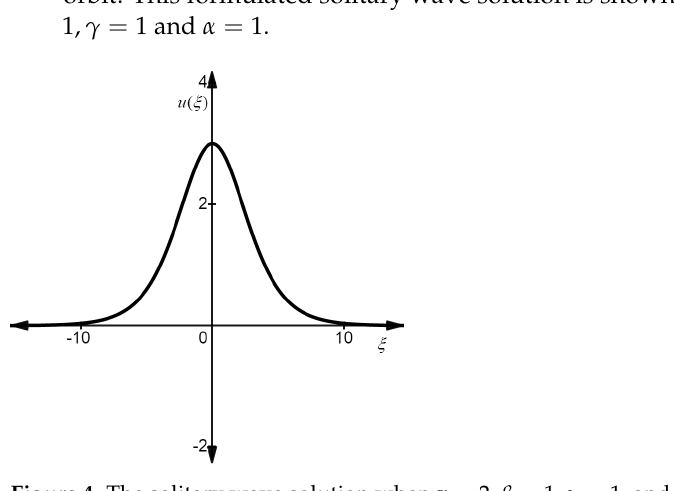
Figure 4. The solitary wave solution when v = 2, β = 1, γ = 1, and α = 1.